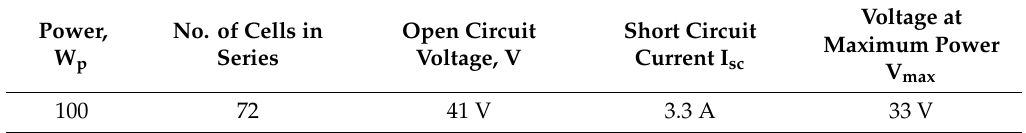
Table 2. Solar PV (100 Wp) data.